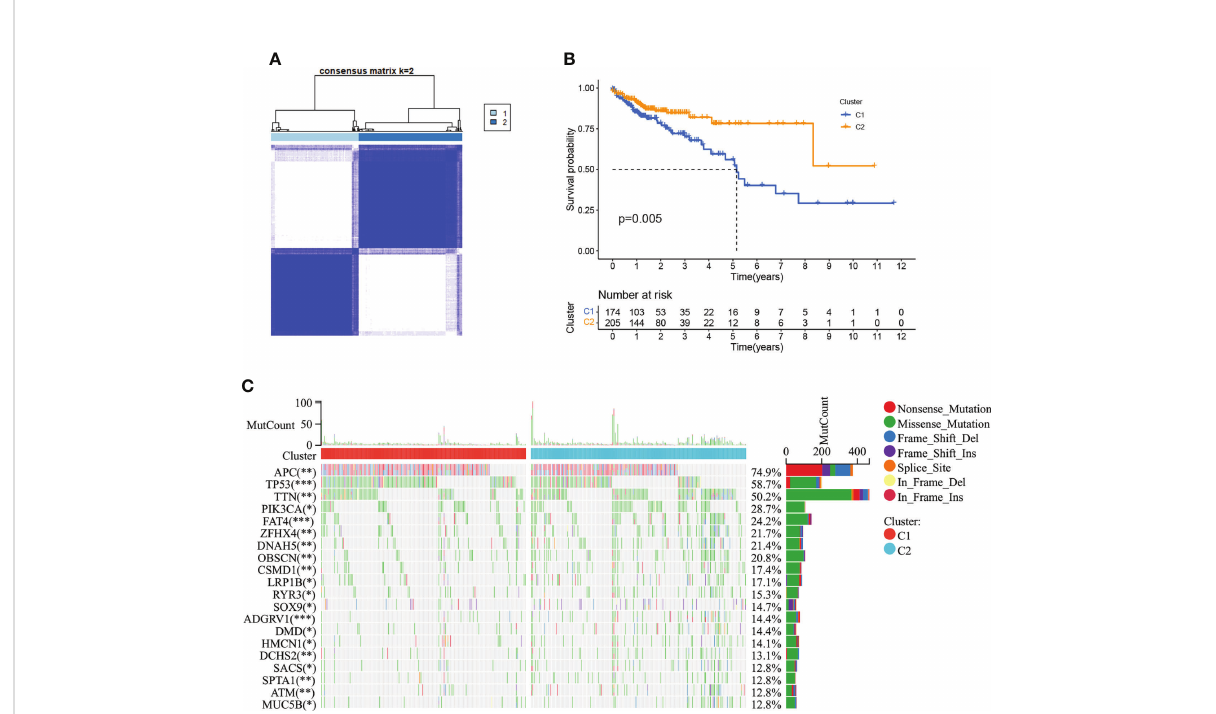
FIGURE 5 Tumor classi fi cation based on the CMRGs. (A) COAD patients were grouped into two clusters according to the consensus clustering matrix (k = 2). (B) Kaplan – Meier curves for the two clusters. (C) The top 20 genes with the highest degree of mutation between C1 and C2. 0 ≤ ****<0 .0001 ≤ *** < 0.001 ≤ ** < 0.01 ≤ * < 0.05 ≤ . <